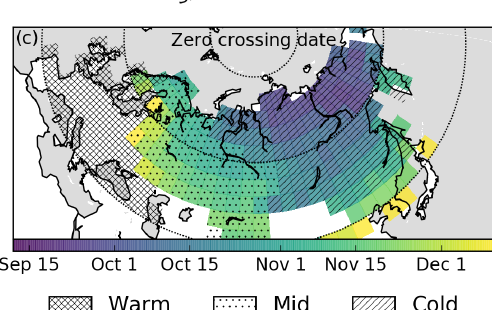
duction (NPP) and heterotrophic respiration ( R h ): NEE = R h − NPP